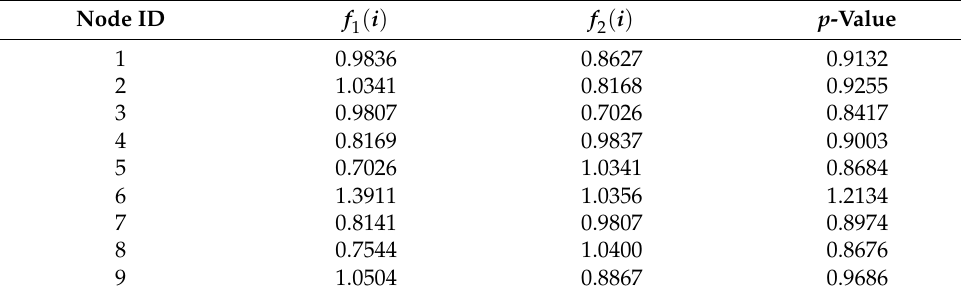
Table 1. Comparison of function values of member nodes in the